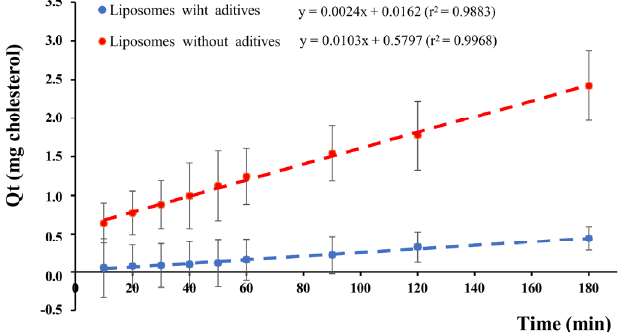
Figure 12. Linear portion of the profiles used for the steady-state flux (Jss) determination (mean ± SD). n =